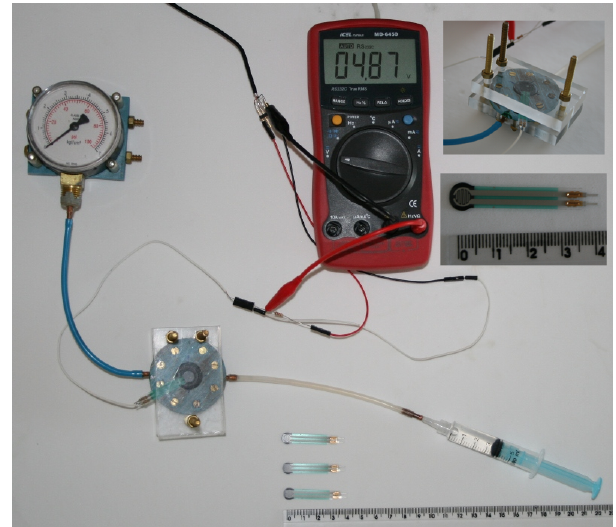
Figure 5. Calibration system in use with a FSR sensor.